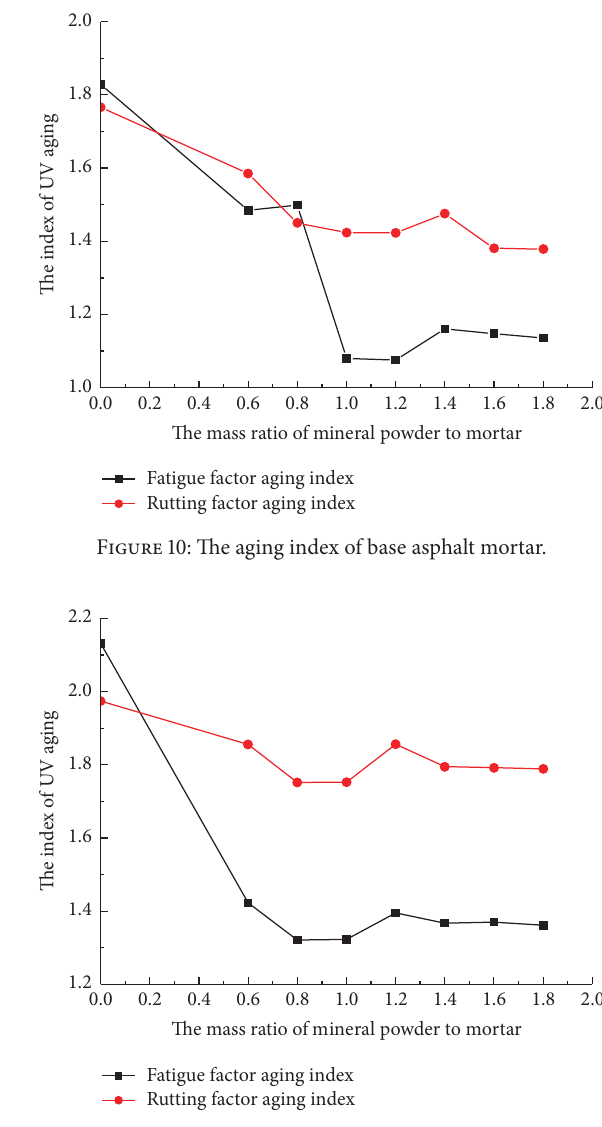
Figure 11: The aging index of modified asphalt